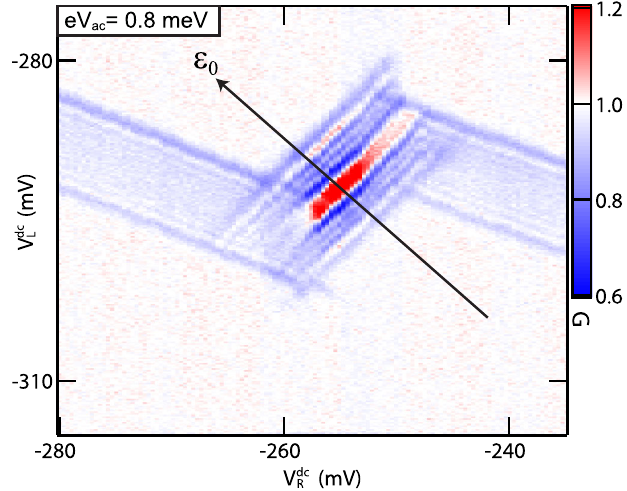
and V dc for L R